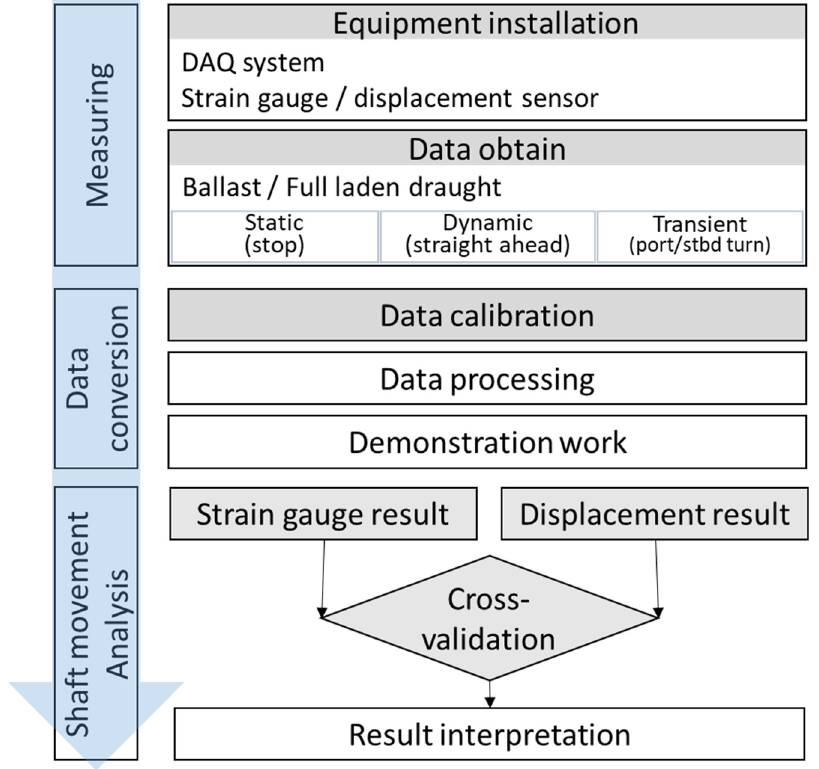
Figure 1. Schematic diagram of the research.